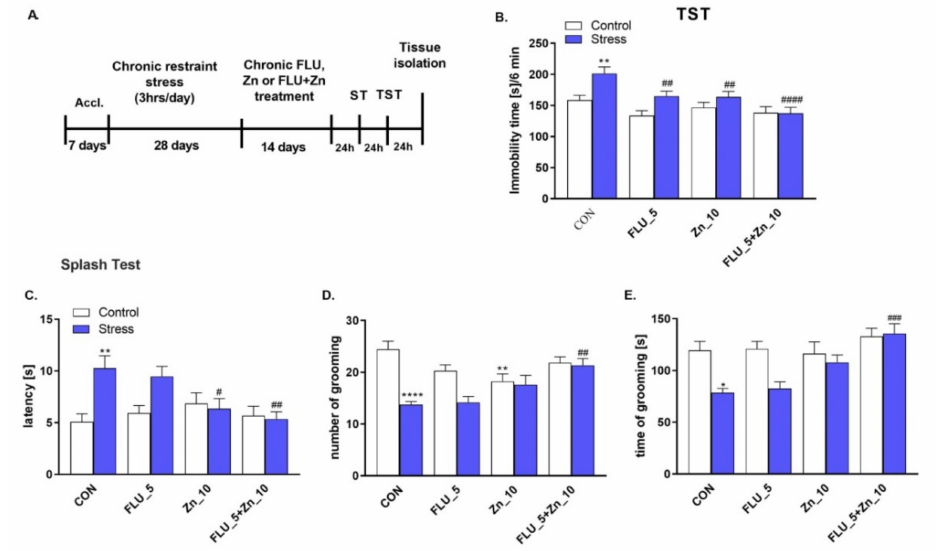
Figure 3. The effect of combined administration of fluoxetine (FLU; 5 mg/kg) and zinc (Zn; 10 mg/kg) on CRS-induced behavioral disturbances. ( A ) Experimental schedule; ( B ) Effects of CRS, FLU and Zn in the TST; ( C – E ) Effects of CRS, FLU and Zn in the ST in mice. Data were